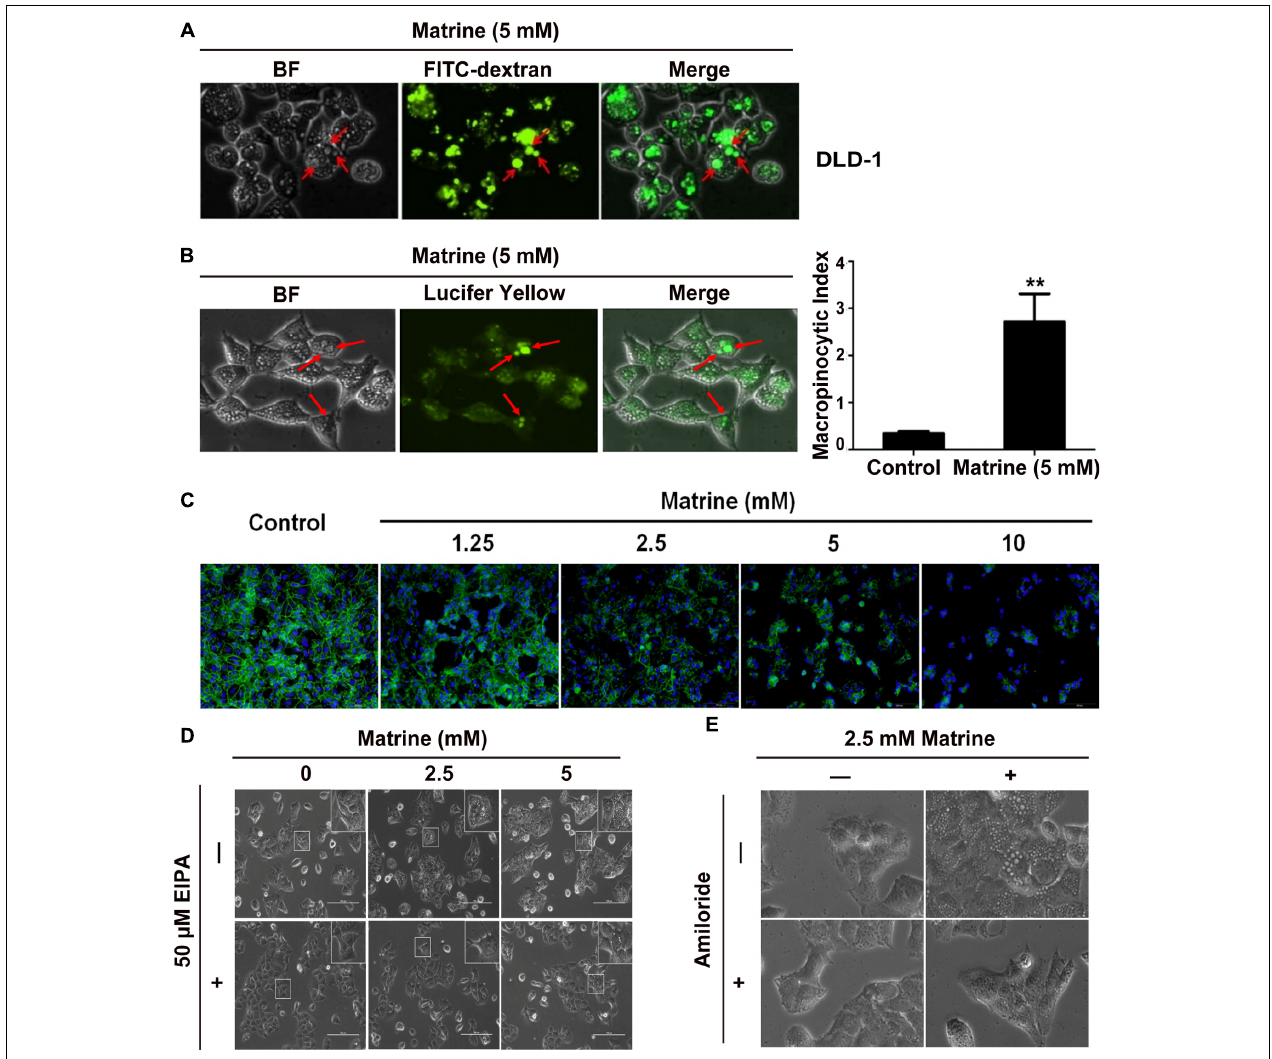
FIGURE 5 | The vacuoles were derived from macropinosomes. (A) Vacuolated cells were preincu-bated with FITC-dextran (green). Arrowhead points to a FITC dextran-containing vacuole. (B) LY accumulation in DLD-1 cells (green). Arrowhead points to a LY-containing vacuole. Macropinocytosis index (MI) was ∗∗ P < 0.01, compared with control. (C) DLD-1 cells were stimulated with 5 mM matrine. Nuclei were stained with DAPI (blue), and cells were stained for actin with rhodamine-phalloidin (red). (D) Effect of EIPA on matrine-induced macropinocytosis. (E) Effect of amiloride on matrine-induced